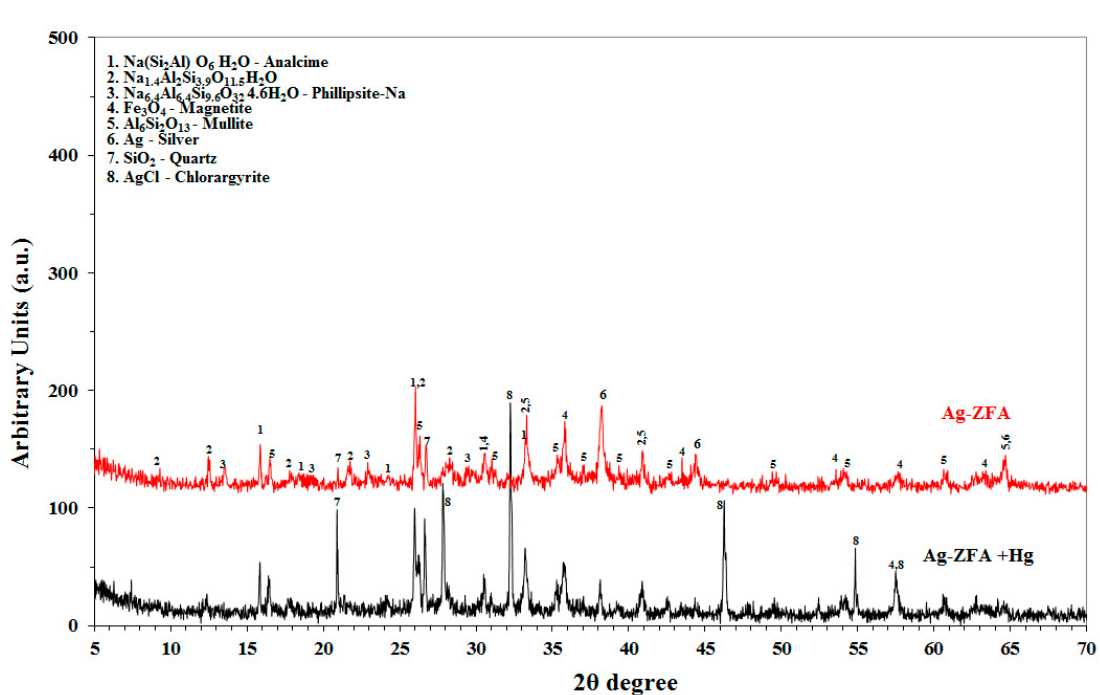
Figure 3. XRD spectra of Ag-ZFA and 4.71 wt.% Ag-ZFA with Hg (II).